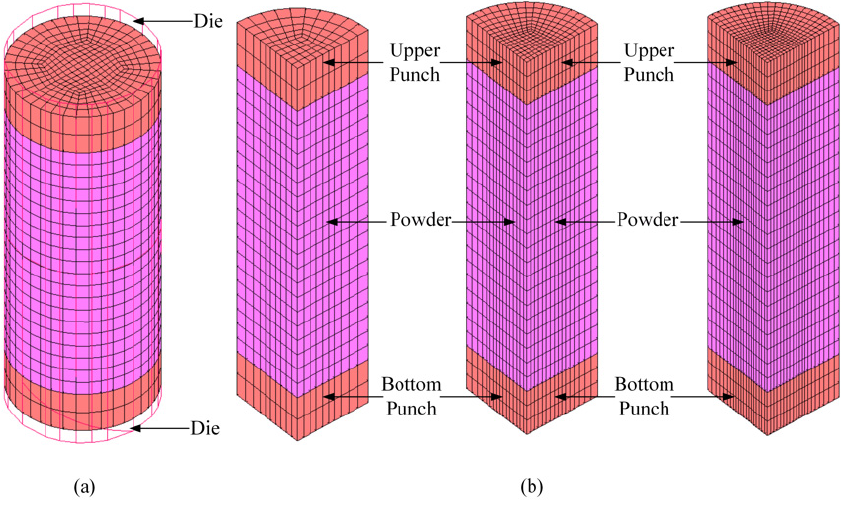
Figure 3. ( a ) Schematic of three ‐ dimensional (3D) finite element (FE) model and ( b ) a ¼ ‐ cylinder model with different mesh sizes.